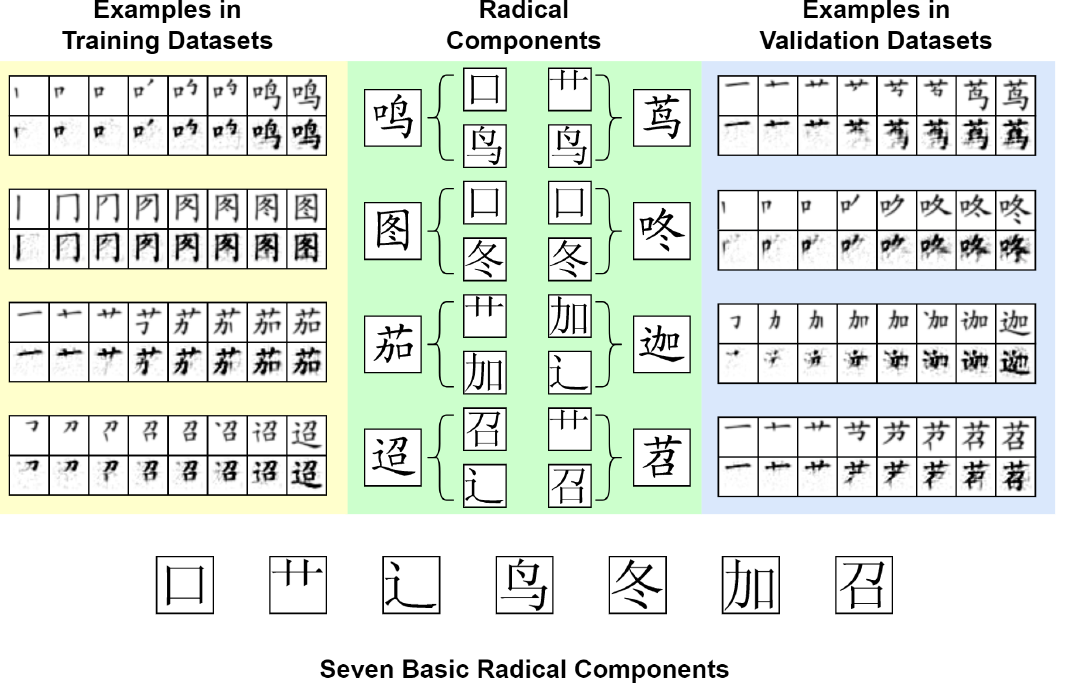
Figure 2. Example results on training (seen class) and validation (unseen class) datasets. Each character has the original picture (above) and reconstructed picture (below). The left column is the Chinese character image in the training datasets, and the right column is the Chinese character image in the validation datasets. The four characters of each column consist of seven basic radical